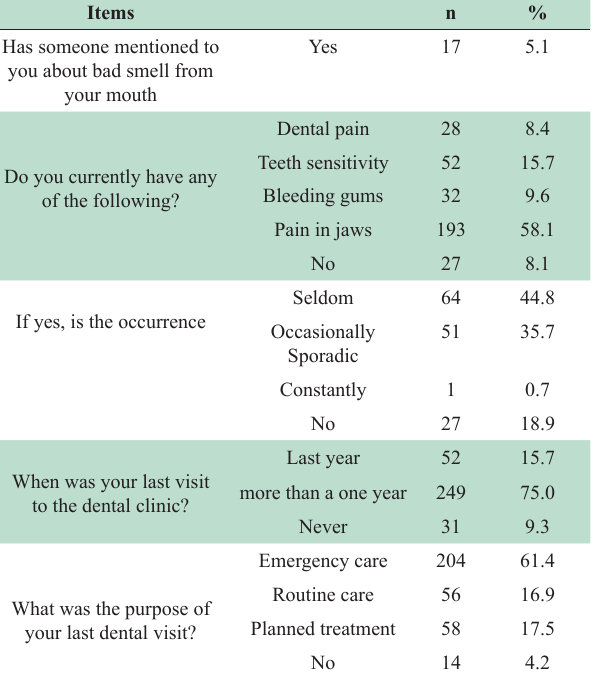
Table-II: Attitude on Smell, Dental Problems and Dental